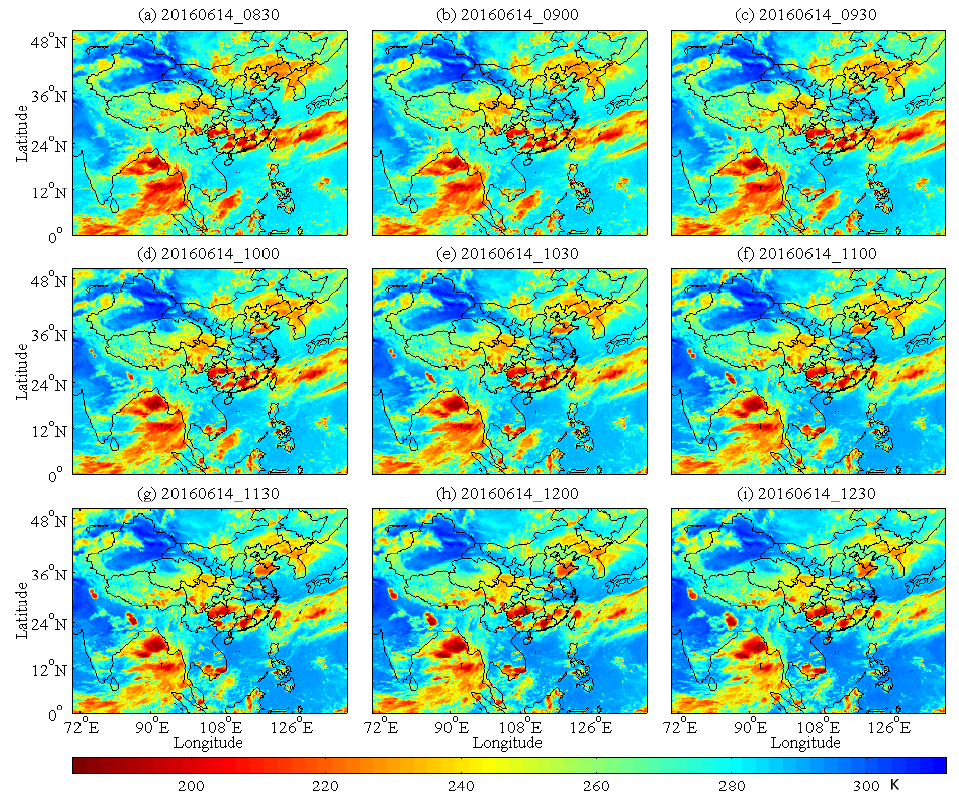
Figure 6. ( a – i ) FY-2F BT IR1 image at every half hour on 14 June 2016, 08:30–12:30. The image at 10:30 is the object to test our detection process in this paper.